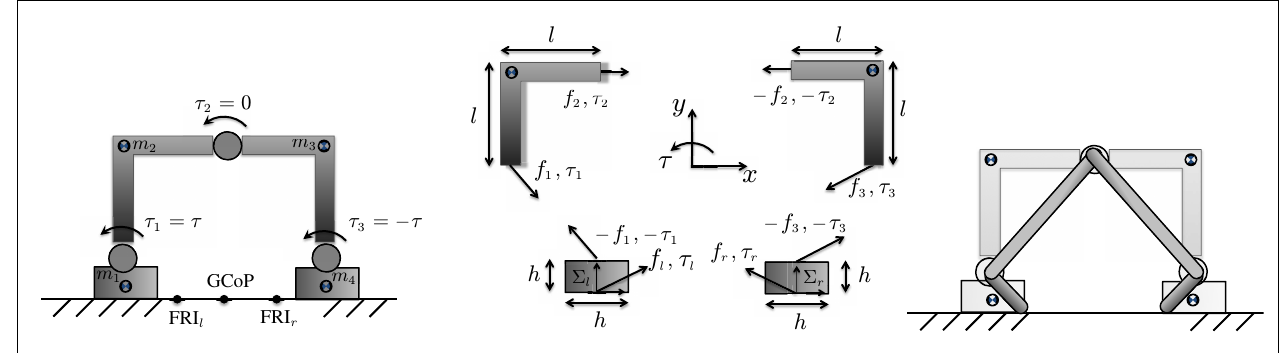
convention and the geometric dimension used in the computations.The contact interaction forces are indicated with f r , f l ∈ R 2 , τ r , τ l ∈ R ; the internal constraint forces are indicated with f 1 , f 2 , f 3 ∈ R 2 . Right figure. The linkage that describes the system kinematic constraints when assuming that the left foot is pivoting around its right edge and the right foot around its left